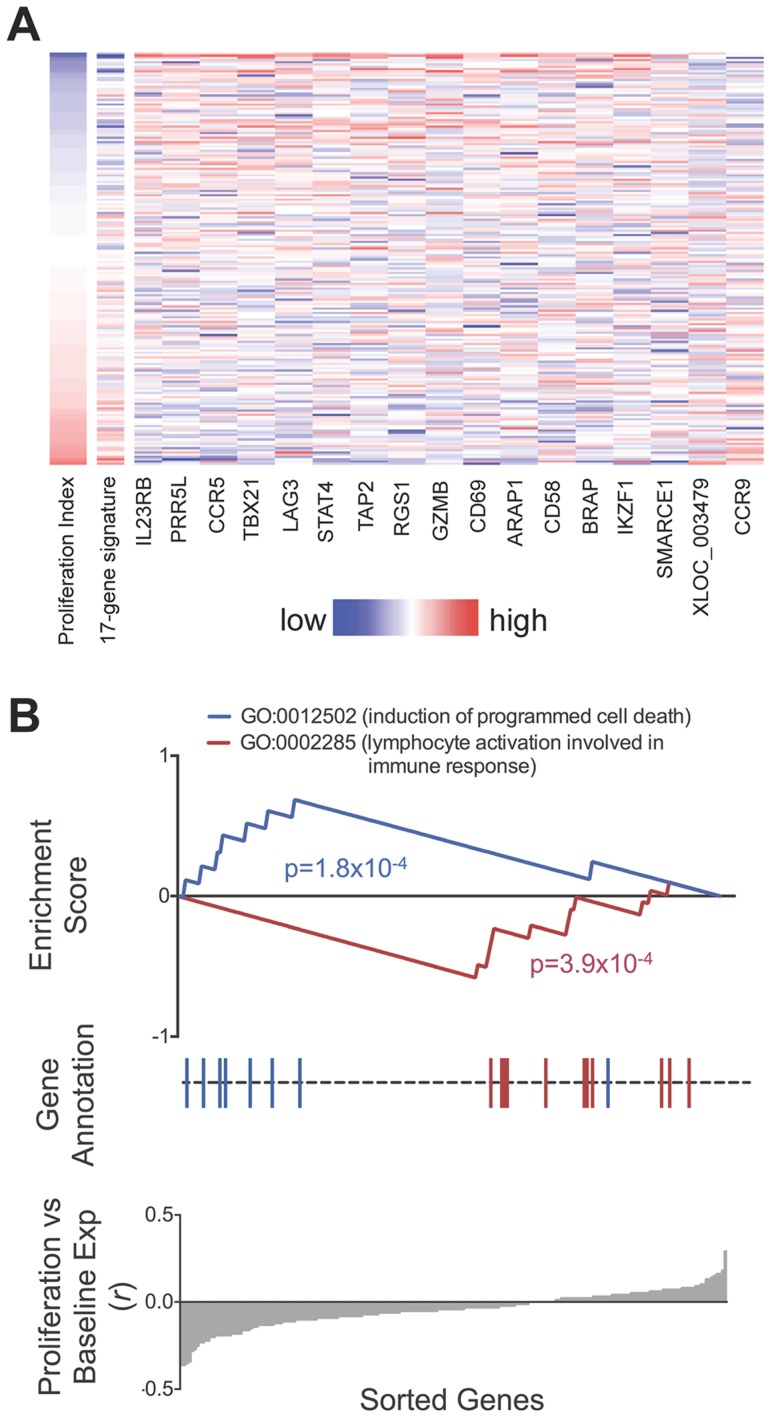
Relationship between baseline expression and post-stimulatory response.
A) Baseline expression of 17 genes correlated with post-stimulation proliferation. Rows in the heatmap are ordered from top to bottom by ascending proliferation index. Genes/columns are ordered from the most negatively correlated (IL23RB) to the most positively correlated (CCR9). The 17-gene signature was calculated as the weighted sum of the 17 genes, where the negatively-correlated genes were given a weight of −1, and the positively-correlated genes were given a weight of +1. Table S1 lists the correlation coefficient and p-value for each gene. B) Genes correlated with proliferative response were enriched for apoptosis and lymphocyte activation pathways. Genes correlated to lower proliferative response (proliferative index) were enriched for Gene Ontology code GO:0012502 (induction of programmed cell death, p = 1.8×10−4). Conversely, genes correlated to higher proliferative response were enriched for GO:0002285 (lymphocyte activation, p = 3.9×10−4).